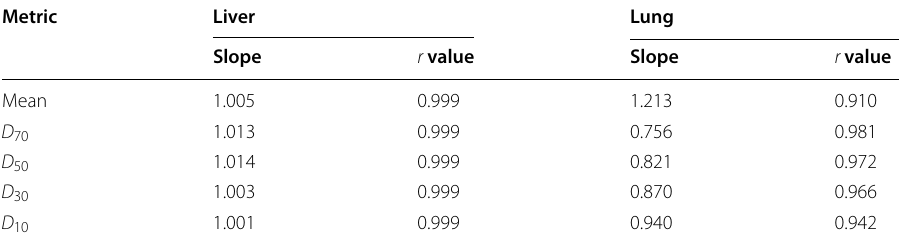
Table 4 Linear regression slopes between the CT and nominal local deposition method was summarized for multiple dose metrics